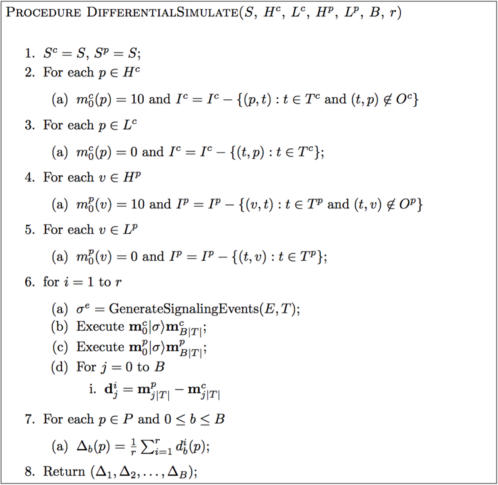
The Algorithm for Predicting the Effect on Signal Propagation of a Targeted Manipulation.The algorithm for predicting the effect on signal propagation of a targeted manipulation on signaling network with connectivity G. The ‘c’ and ‘p’ superscripts are used to denote parameters in the control and perturbed versions, respectively, of the SPN.